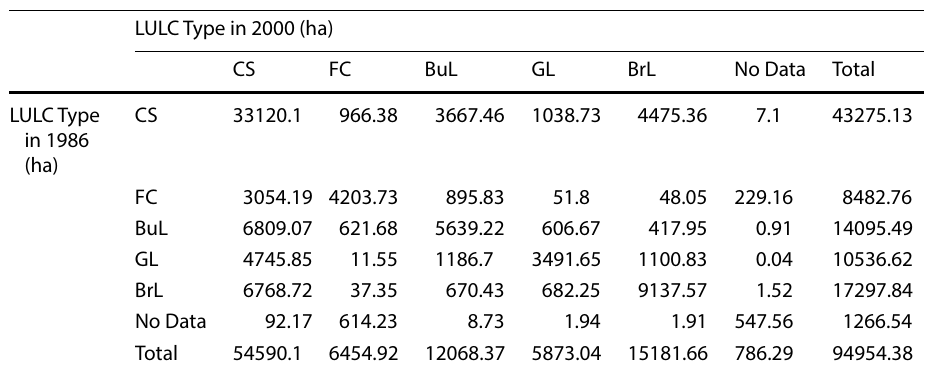
CS = Cultivated & Settlement, FC = Forest cover, BuL = Bush land, GL = Grazing Land, BrL =